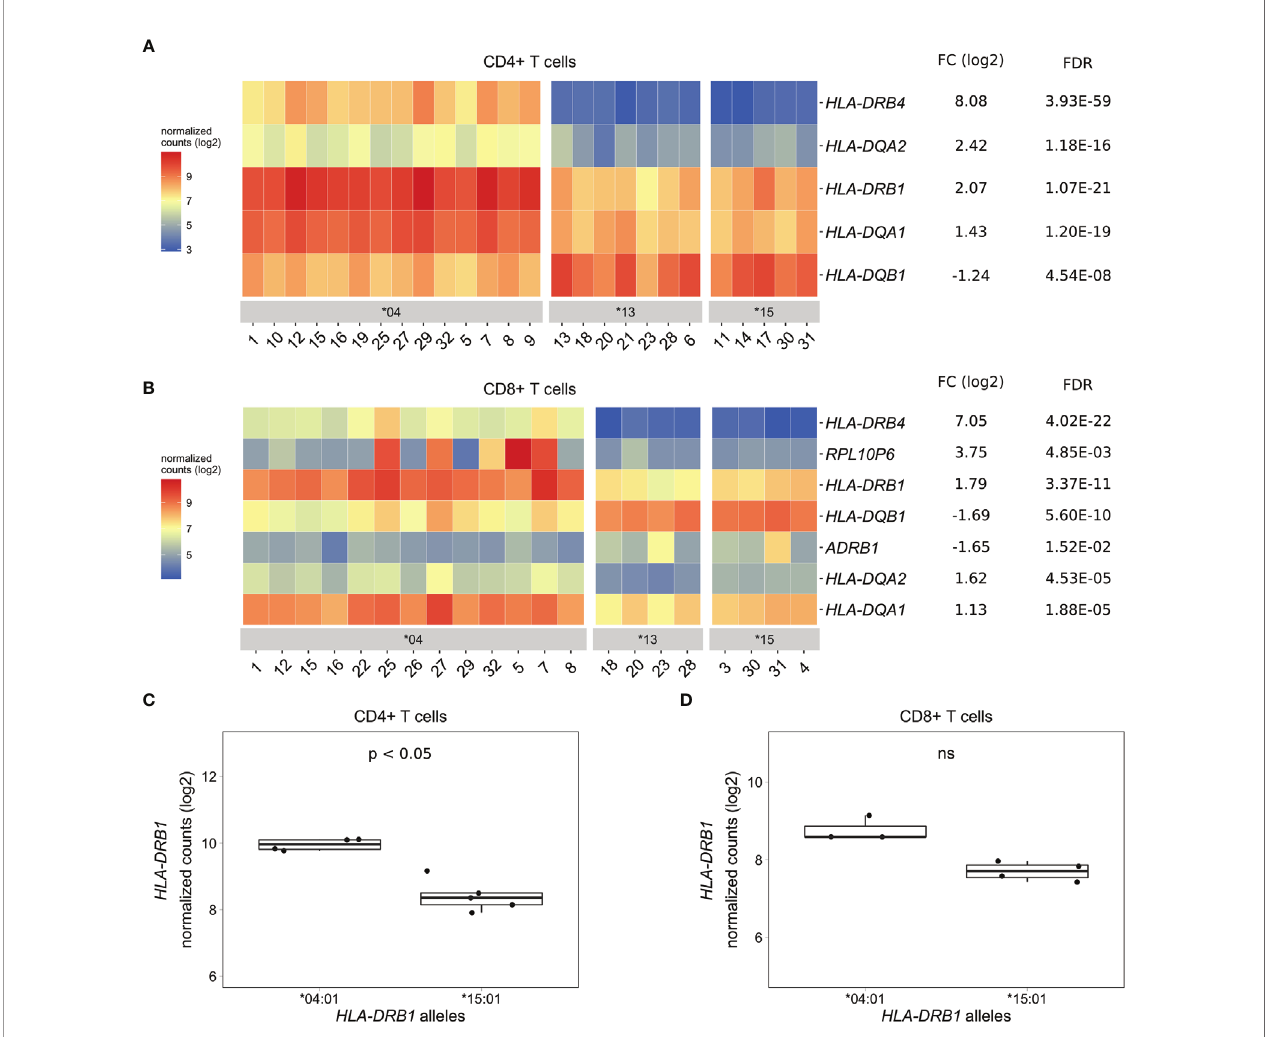
FIGURE 3 | Differentially expressed genes in CD4+ and CD8+ T cells of HLA-DRB1 SE-positive versus SE-negative healthy individuals. (A) Heat map of differentially expressed genes (log transformed normalized gene counts) in CD4+ T cells of HLA-DRB1 SE-positive [*04 ( n = 14)] versus SE-negative [*03:01/*13:01 and *03:01/ *15:01 ( n = 12)] individuals. (B) Heatmap of differentially expressed genes (log transformed normalized gene counts) in CD8+ T cells of HLA-DRB1 SE-positive [*04 ( n = 13)] versus SE-negative [*03:01/*13:01 and *03:01/*15:01 ( n = 8)] individuals. In both heatmaps, genes shown in red have higher gene counts and those shown in blue have lower gene counts. (C) HLA-DRB1 gene expression in CD4+ T cells of HLA-DRB1 SE-positive [*03:01/*04:01 ( n = 4)] and SE-negative [*03:01/*15:01 ( n = 5)] individuals. (D) HLA-DRB1 gene expression in CD8+ T cells of HLA-DRB1 SE-positive [*03:01/*04:01 ( n = 3)] and SE-negative [*03:01/*15:01 ( n = 4)] individuals. FC, fold change; ns, non-signi fi cant adjusted P -value